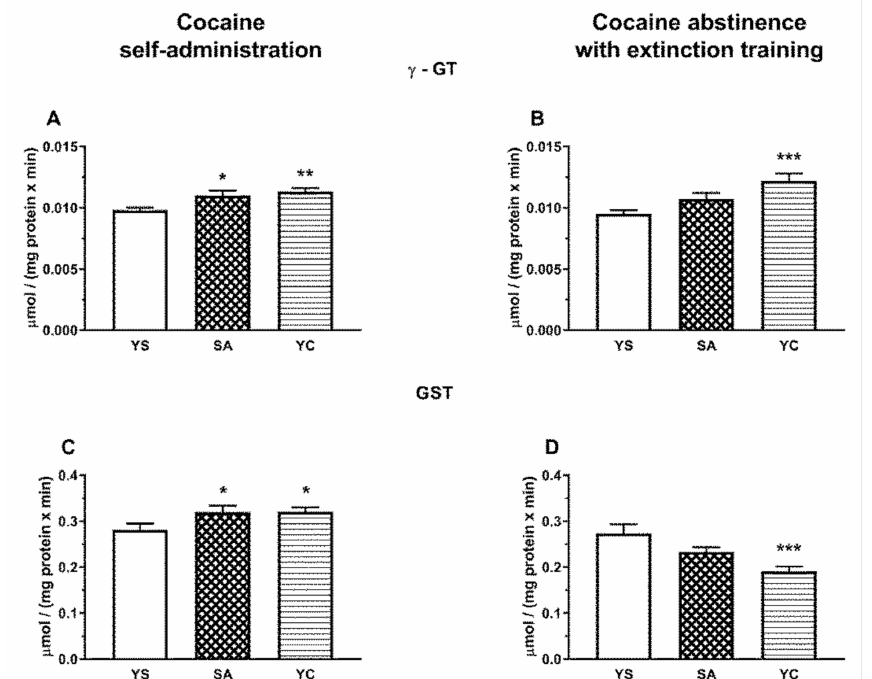
Figure 11. The activity of γ -GT and GST in the presence of cocaine ( A , C ) and after 10 days of drug abstinence with extinction training ( B , D ) in the livers of rats self-administering cocaine (SA), receiving passive cocaine infusions (YC), and receiving saline infusions (YS). Data are presented as the mean ± SEM, n = 8–10 per group. * p < 0.05, ** p < 0.01, *** p < 0.001 vs. YS group.